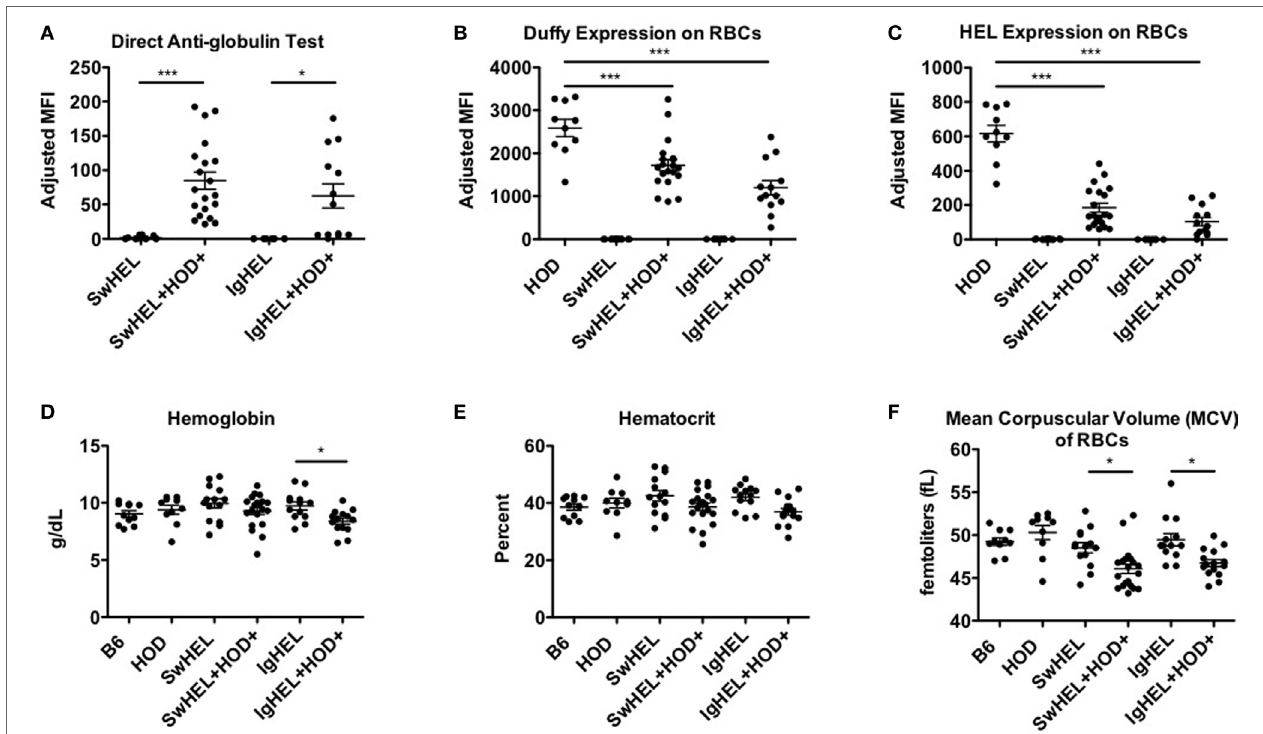
FigUre 5 | Autoantibodies effect red blood cell (RBCs). To determine whether the presence of autoantibodies affected erythrocytes, RBCs from experimental mice were collected and assayed for (a) antibodies bound to their surface and surface expression of (B) Duffy and (c) hen egg lysozyme (HEL) antigens. To assess whether autoantibodies affect RBCs, a hematology profile was generated with a HemaVet. RBCs from experimental mice were evaluated for (D) hemoglobin, (e) hematocrit, and (F) mean corpuscular volume (MCV). Scatter dot plots shown are compiled from three independent experiments with at least three mice per group. Selective p values are shown on graphs and * ≤ 0.05, ** ≤ 0.01, and *** ≤ 0.001. For complete statistical analysis with all significant differences, see Table S5 in Supplementary